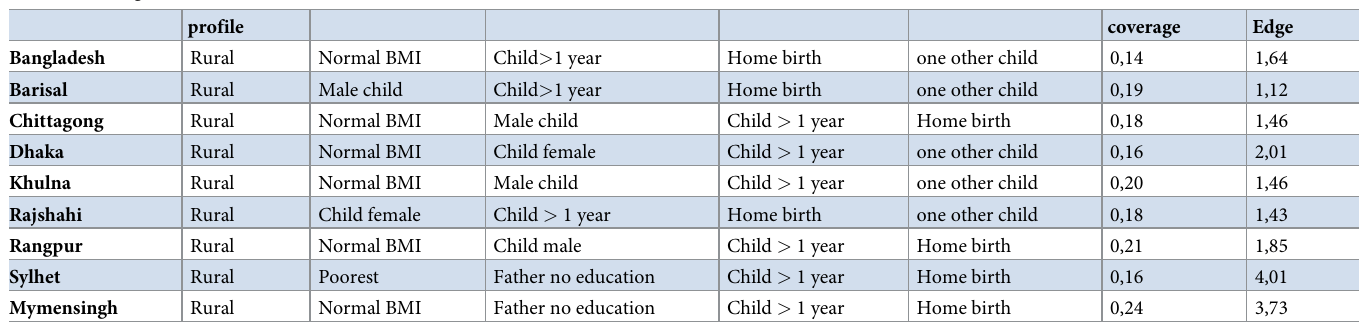
Table 2. Polling results from 2014 BDHS (new